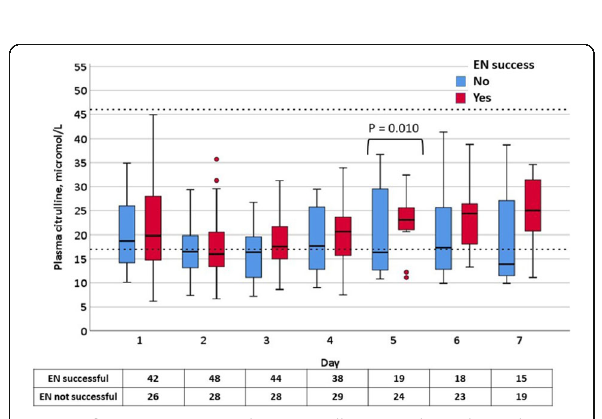
Fig. 3 (abstract 000298). Plasma citrulline in early (within 48h) enternal nutrition/oral